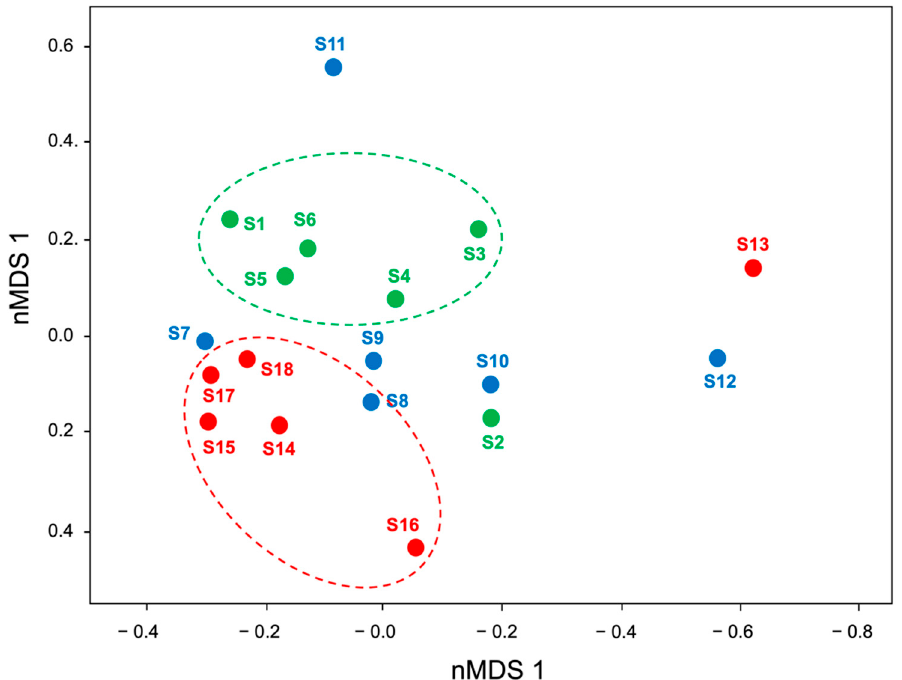
Figure 3. Nonmetric multidimensional scaling (nMDS) analysis of bacterial communities in tissue samples of Choromytilus chorus specimens grown in natural bank from Nehuentue Estuary (S1~S6, green dots), and natural bank (S7~S12, blue dots) and long–line system (S13~S18, red dots) from Hueihue Bay. The plot was generated by free packages of R software v 1.3.1093 (https://www. rproject.org/) with the Bray-Curtis similarity